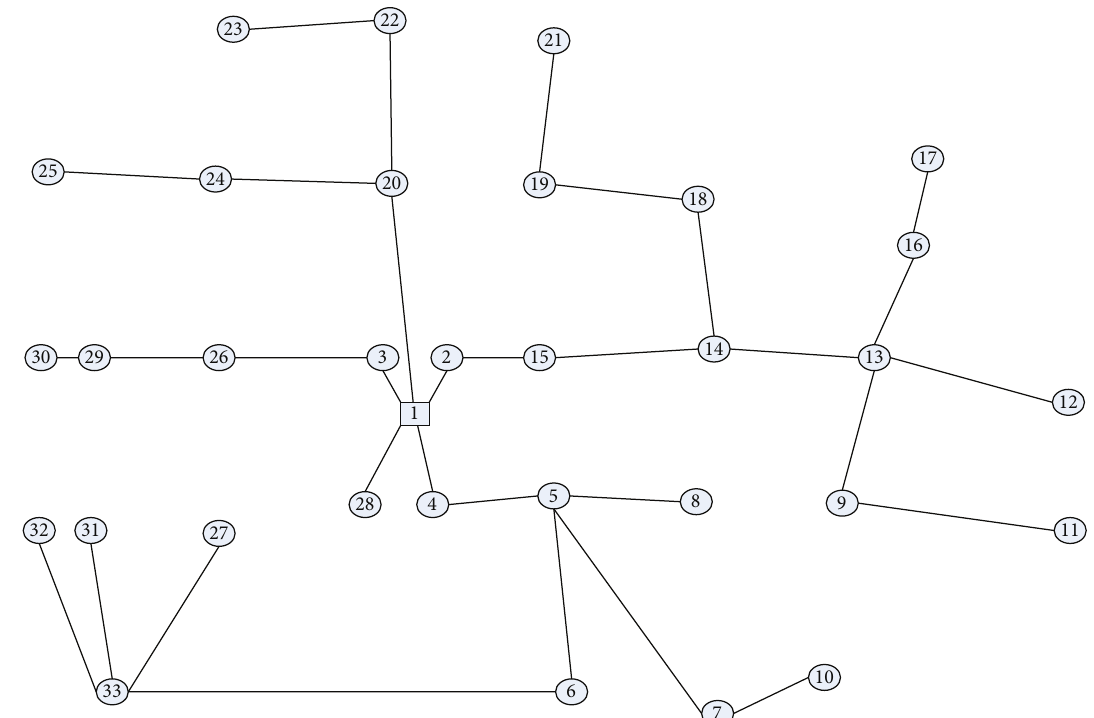
Figure 2: The optimal distribution network planning based on the HIS